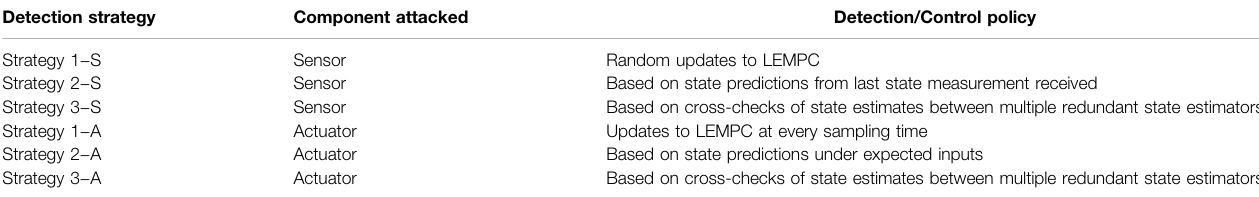
TABLE 1 | Single attack-type cyberattack detection strategies described. Detection strategy Component attacked Detection/Control policy Strategy 1 −